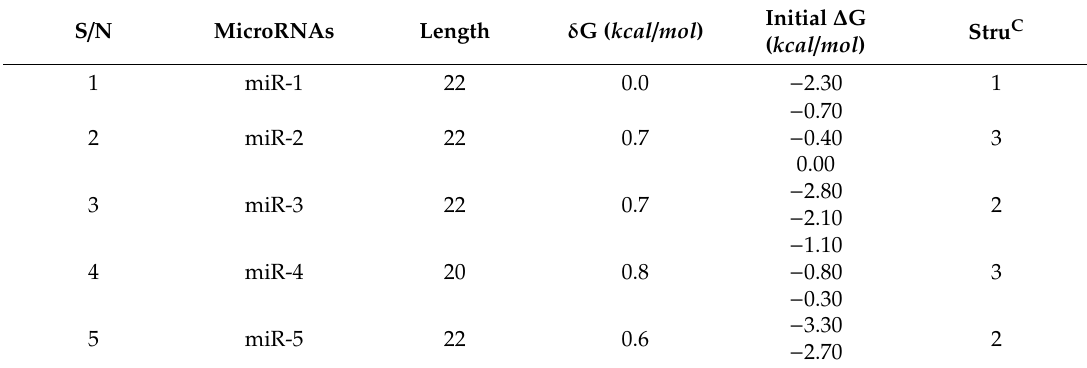
Table 1. Parameters and secondary structures of the microRNA